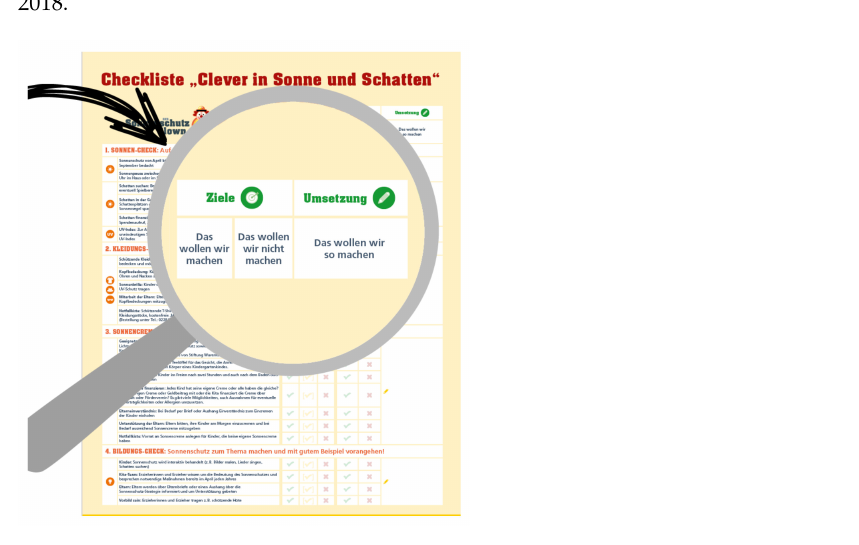
Figure 7. CLEVER-checklist fosters goal-setting and detailed planning for the institutions’ individual sun protection strategy © NCT/UCC